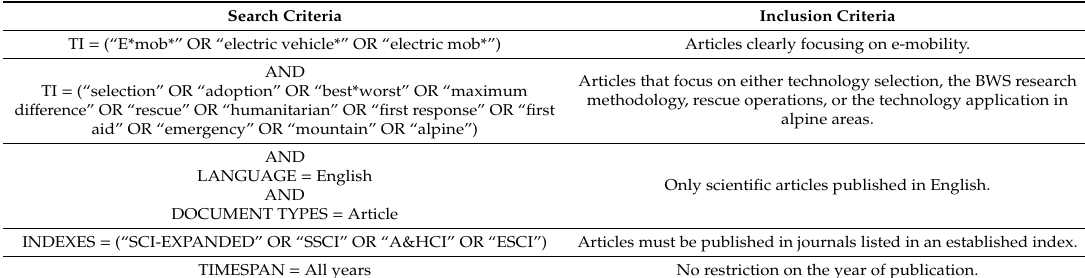
Table A1. Search string used for initial attribute